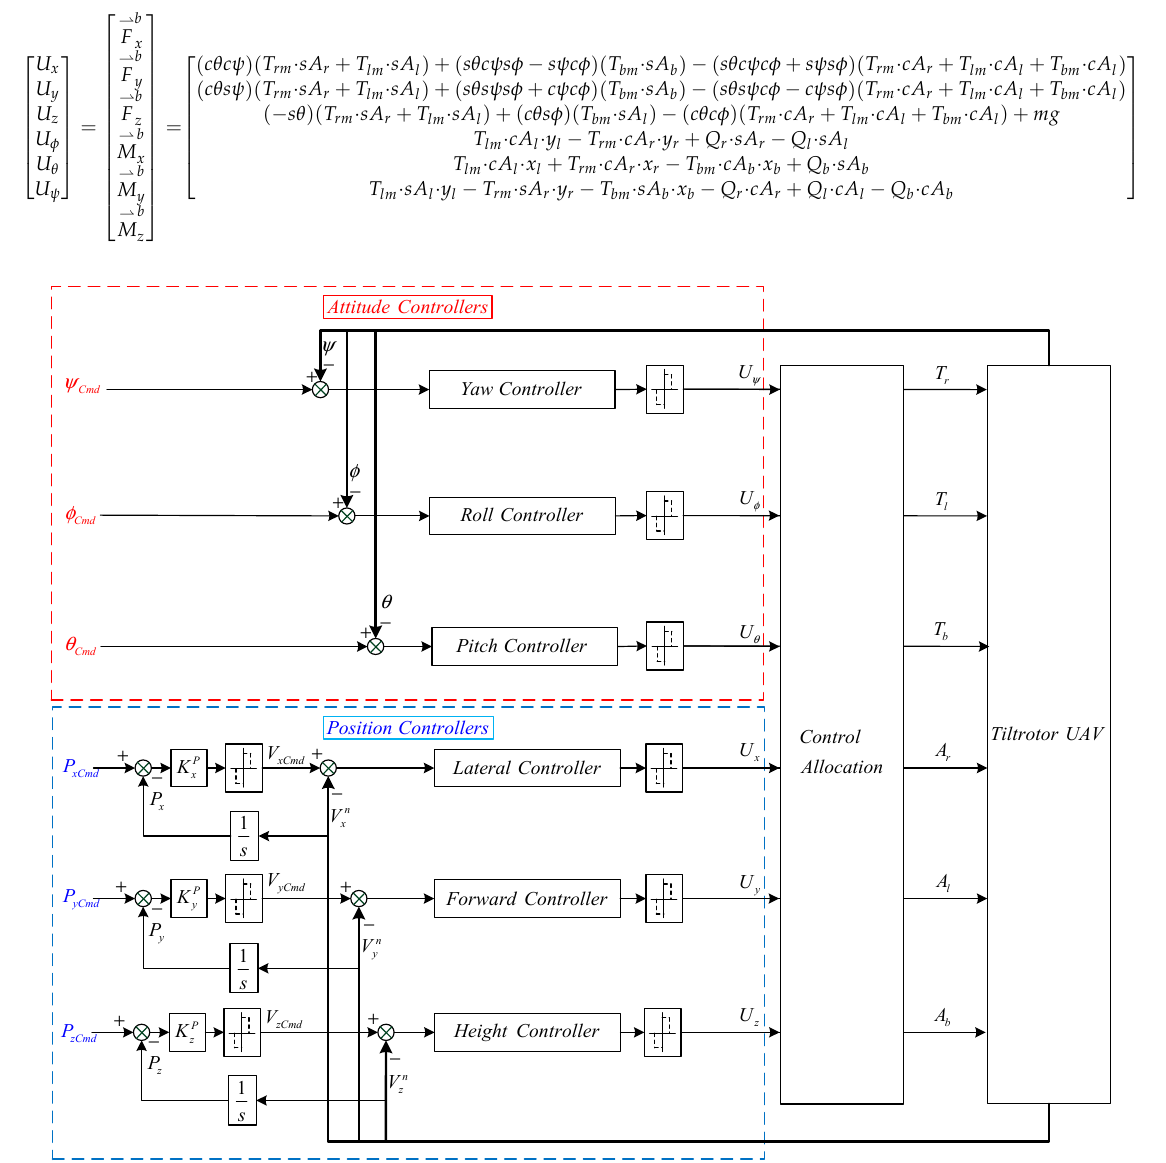
Figure 4. Structure diagram of the DTVC scheme in the VTOL phase.